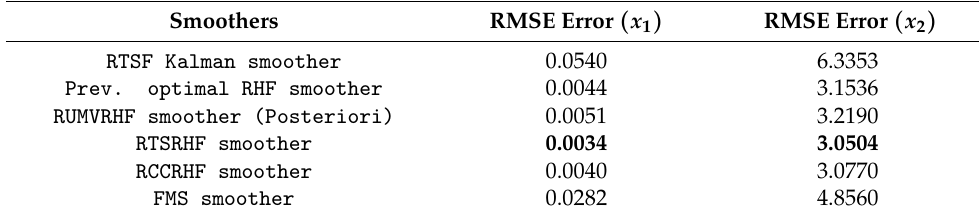
Table 6. RMSE errors of smoothers for the time interval [ 200 350 ] .